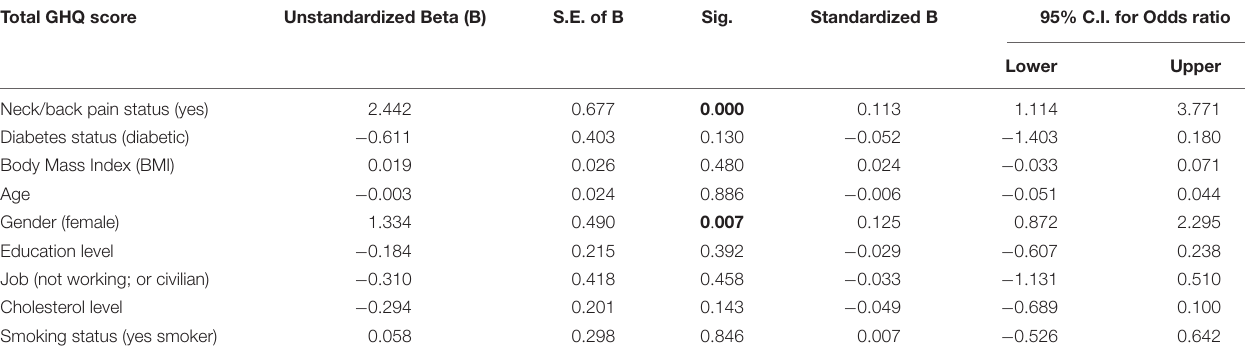
TABLE 7 | Multiple linear regression model regressing total GHQ score on neck/back pain status and sociodemographic and other variables ( n = 1,018). Total GHQ score Unstandardized Beta (B)